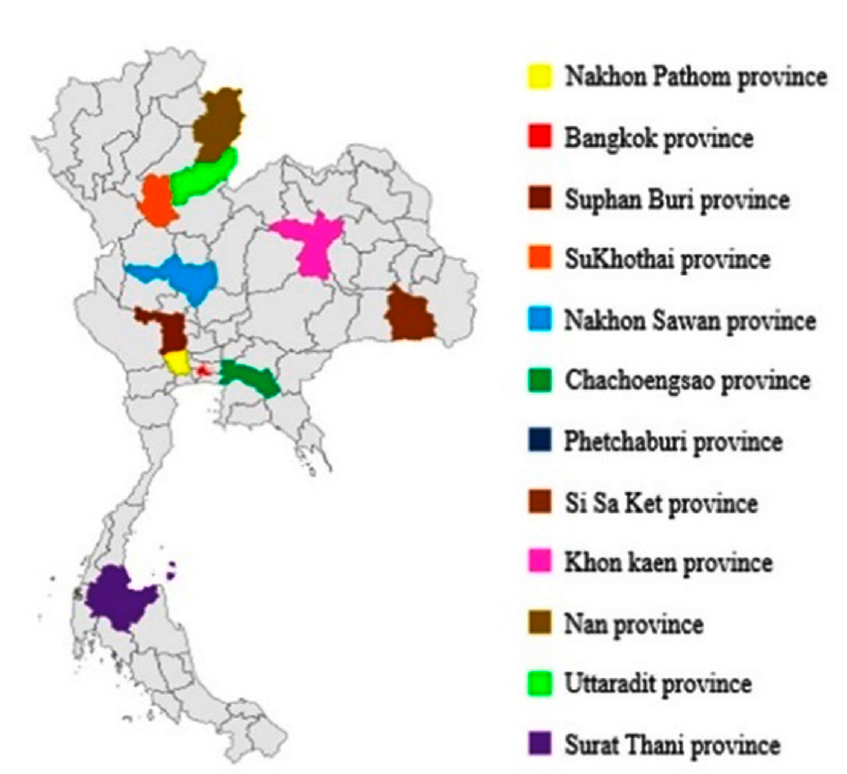
Fig. 1. Locations of Look-pang-khao-mak samples were collected in 12 provinces in